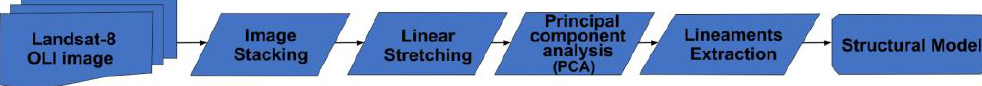
Figure 3. Flowchart methodology of the study.